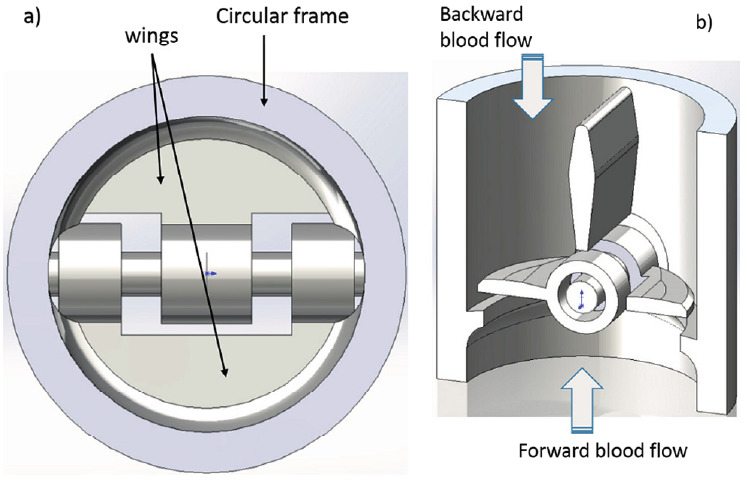
Figure 1. Three dimensional computer-aided design of the micro-valve. ( a ) cross sectional view of the whole micro-valve, and ( b ) view of the one half of the